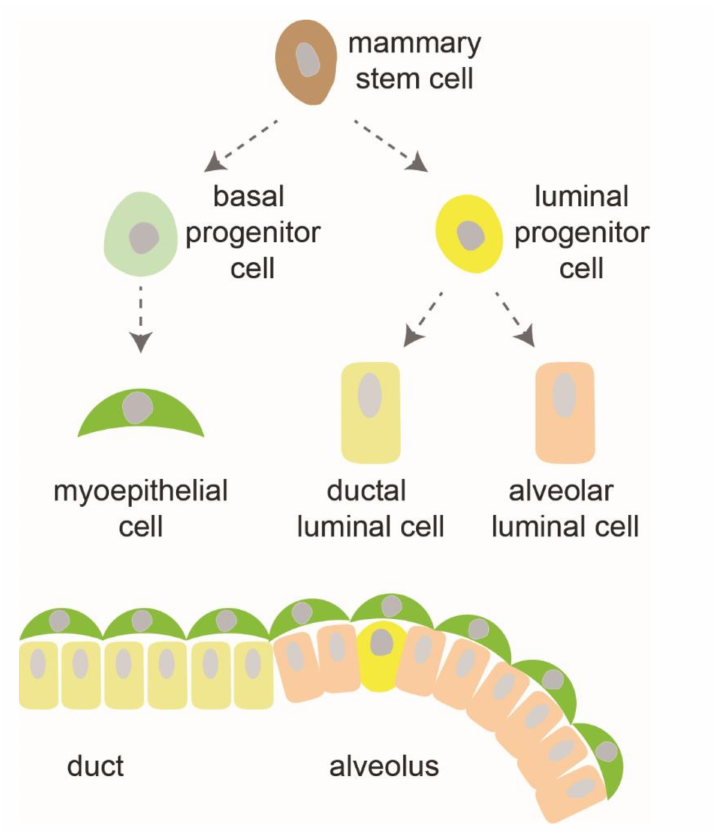
Figure 1. Cell differentiation hierarchy in mammary gland